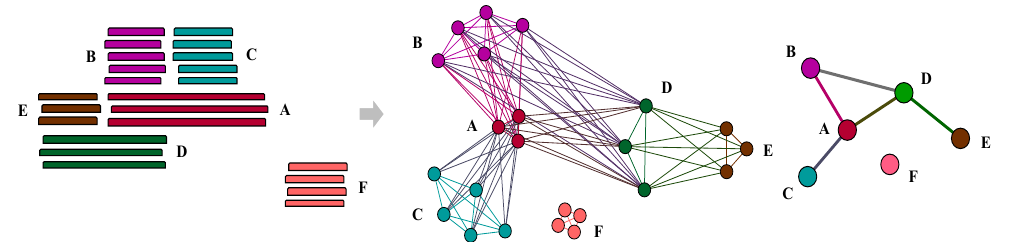
Figure 2. Sample patterns of nested composite, strict composite, strict component, and non-remodelled gene families. Genes in family A not only participate in the fusion of genes in family D as component genes but are also formed by genes from family B and C as composite gens; this is regarded as nested composite genes. In contrast, genes in family B, C and E belong to strict component families which only act as component genes in this network. Similarly, genes in family D as members of a strict composite family. In additional, family F is non-remodelled gene. Also, because there is no overlap between gene family A and C, gene family B and E so ‘A-B-C’ and ‘B-D-E’ can be regarded as non-transitive triplets.